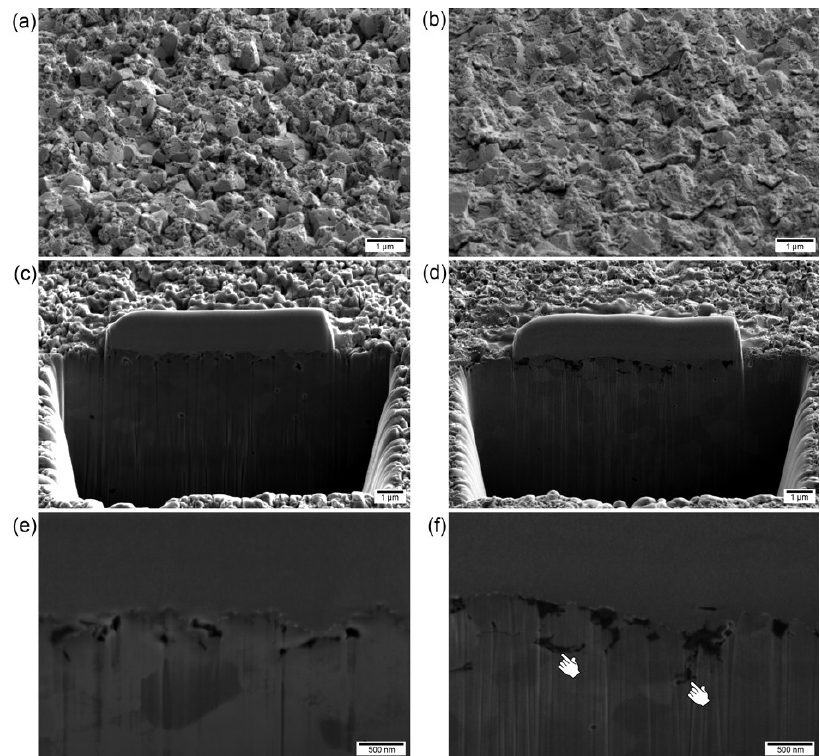
Figure 8. Scanning electron micrographs (SEM) of 30F30 specimens etched (left) and debonded (right): ( a , b ) surface images (20,000× magnification, bar = 1 μm), ( c , d ) overview of cross-sections prepared by FIB (15,000× magnification, bar = 1 μm), ( e , f ) enlarged cross-sections (50,000× magnification, bar = 500 nm). In Figure 8f, the pointers indicate incomplete resin infiltration into the